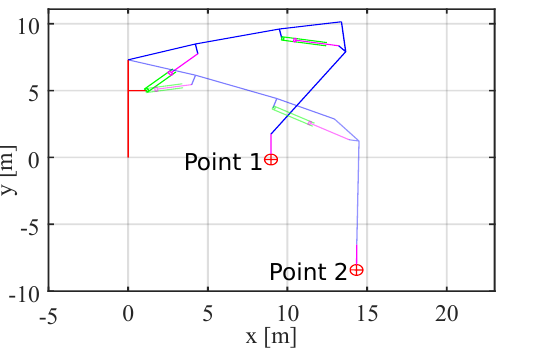
Figure 11: The load is moved from 1 to 2 and back to 1. Donkov et al. (2018).